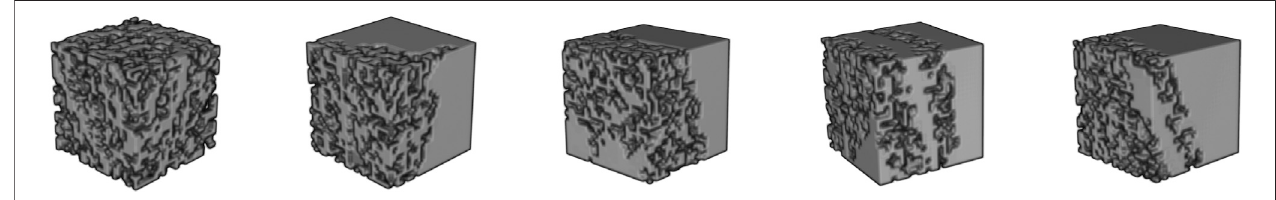
FIGURE1| Three-dimensionalvisualizationofCTdatacorrespondingtodifferentareasofthebone:porositydecreasesfromlefttoright, which,accordingly,leads to an increase in the bone volume